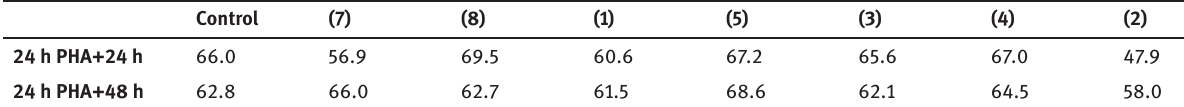
Table 4 : The cumulative percentage of PBL in G0 and G1 phase of cell cycle stained with AO and analyzed by flow cytometry. Control